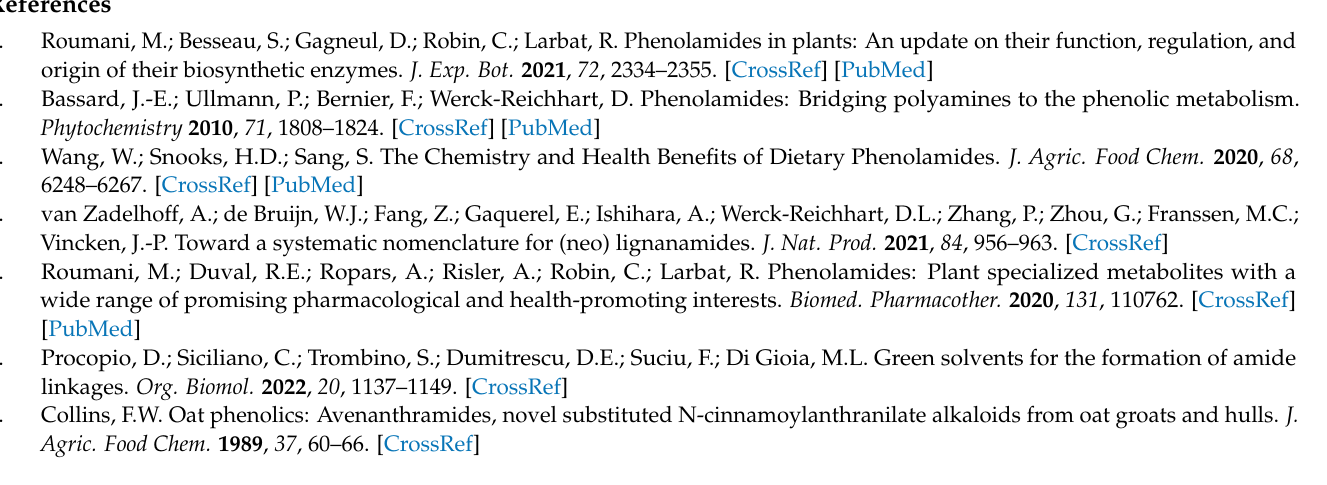
Figure S11: DSC data obtained for the isolated phenol amides. Figures S13–S19: 1 H and 13 C NMR spectra for the isolated phenol